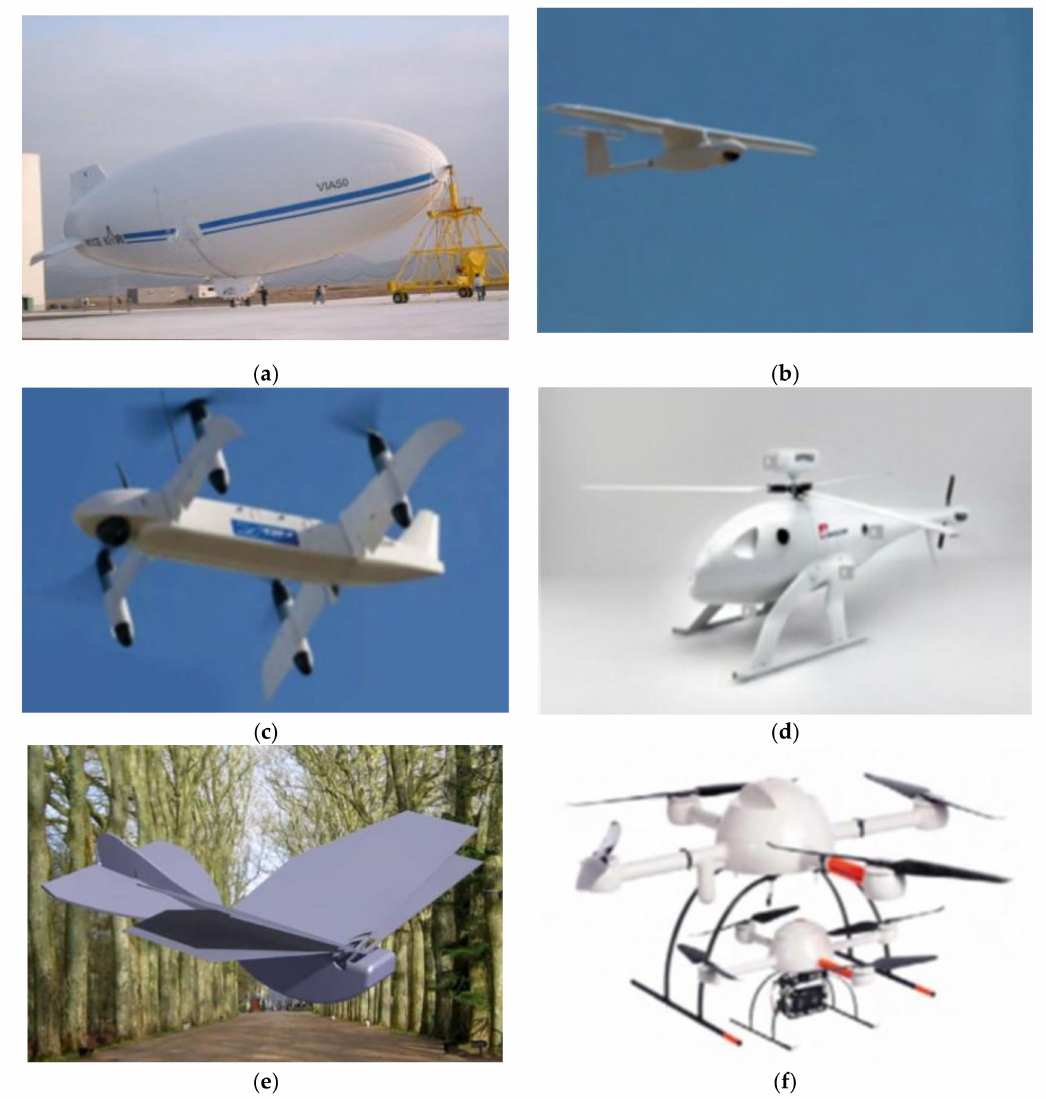
Figure 2. Main types of UAVs: ( a ) unmanned airship; ( b ) fixed-wing; ( c ) tilt-wing; ( d ) unmanned helicopter; ( e ) flapping-wing; and ( f ) multi-copter